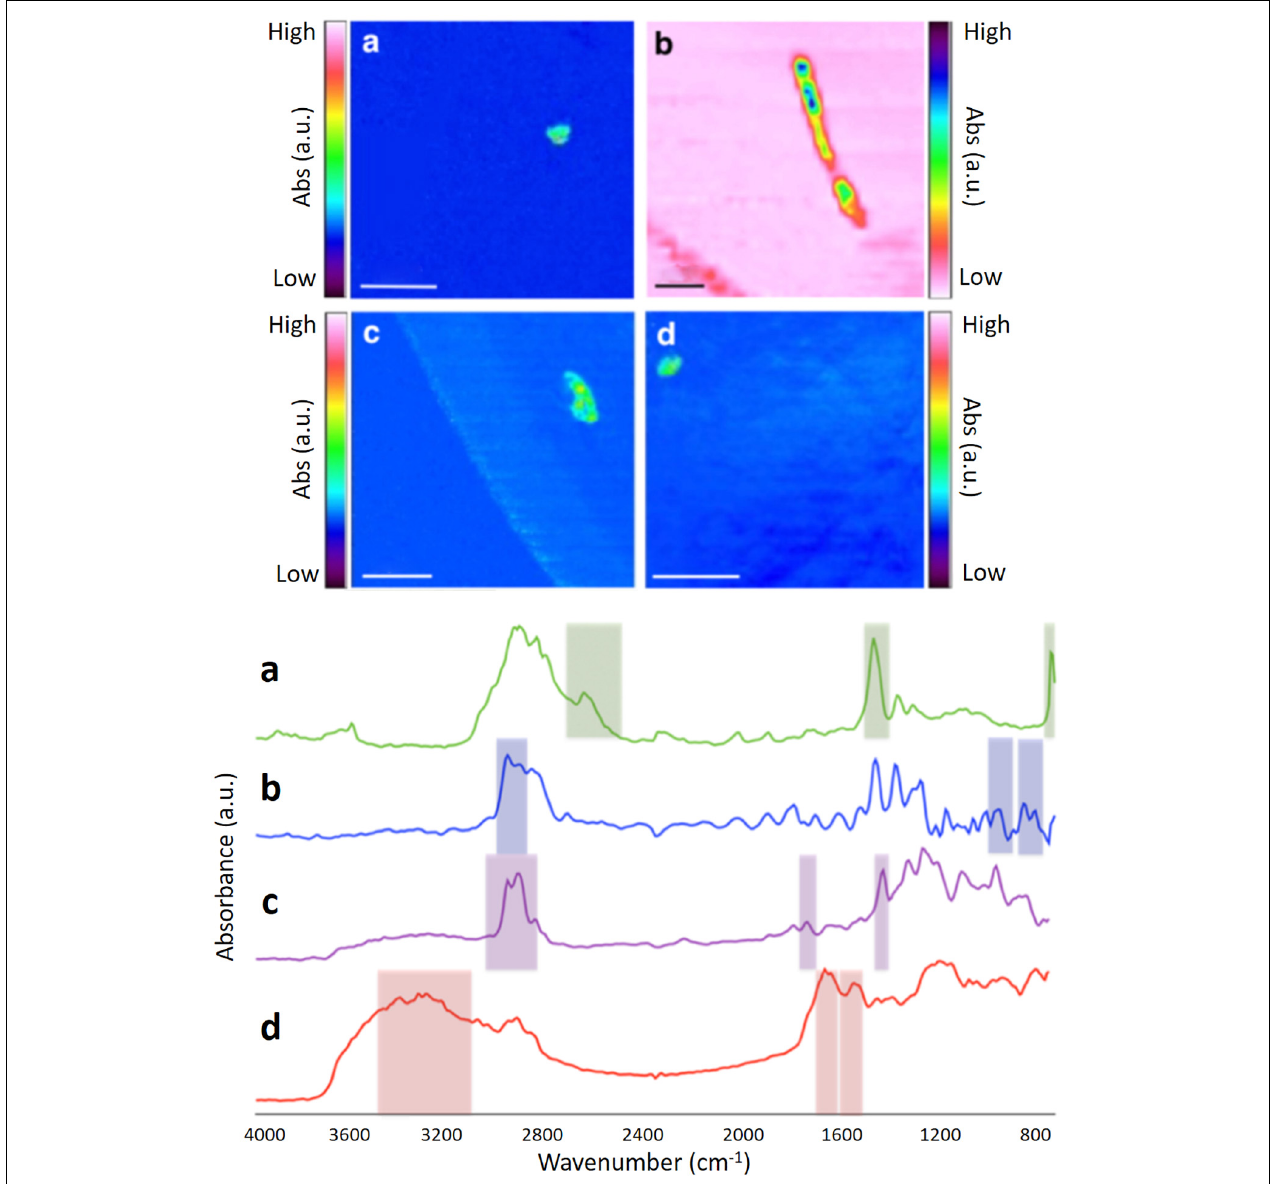
FIGURE 1 | FPA-based micro-FTIR false-color images of microplastics found in the WWTP, generated using key spectral-peak selections (see Supplementary Material for details). Corresponding spectra of different polymer types are shown below the false-color images. (a) PE; (b) PP; (c) PVC; (d) Nylon. Scale bar = 1